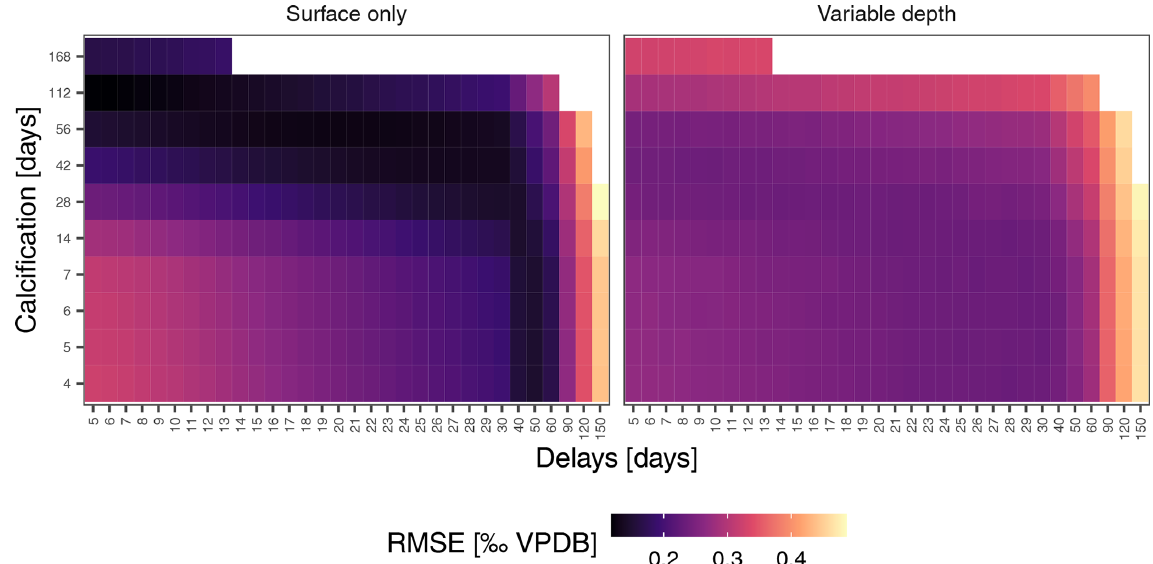
Figure 6. Mean foraminifera δ 18 O constrains simulations. Prediction errors for sample mean δ 18 O reach markedly lower values for the surface-only simulations, indicating that this scenario is more likely to characterise N. pachyderma in the Irminger Sea. This means that the observed variability (Fig. 4) is unlikely a reflection of temperature and δ 18 O seawater variability alone and that the δ 18 O of individual N. pachyderma shells is not a precise indicator of environmental conditions during